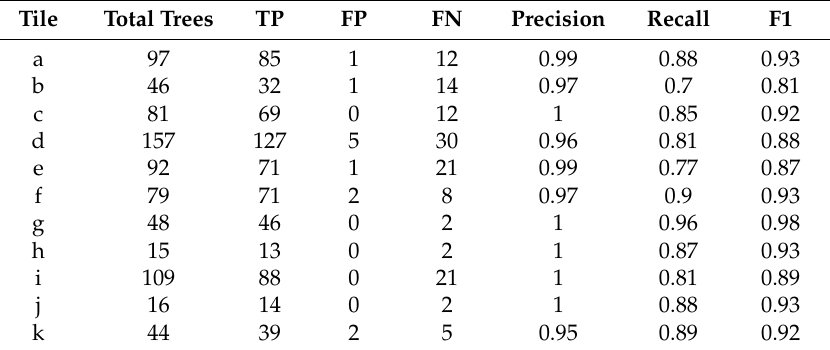
Table 4. Evaluation metrics for the instance of Mask R-CNN trained with the Balloon pretrained network where all layers were adjusted during training. TP = true positive; FP = false positive; FN = false negative.